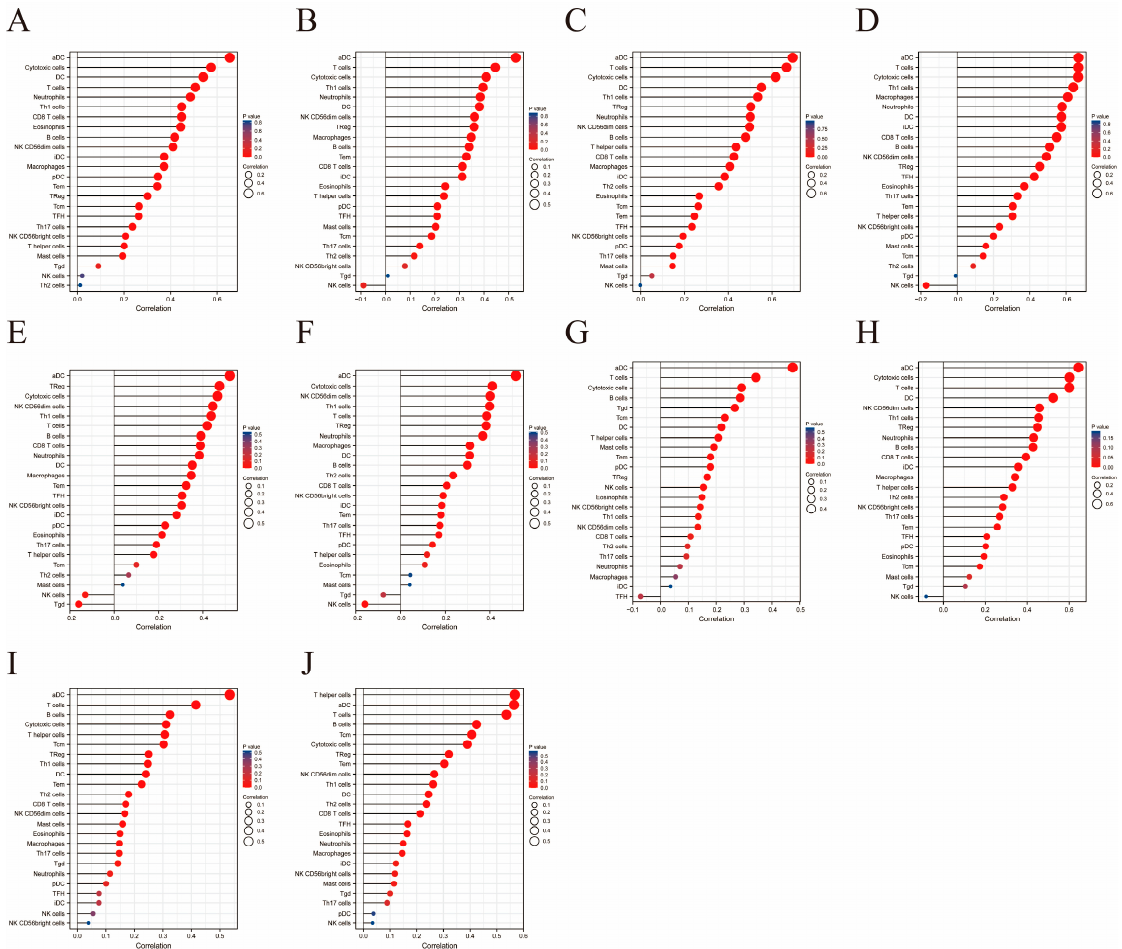
Figure 5. Immune cell infiltration analysis performed on the ten hub genes, presented in the form of lollipop charts. ( A – J ) Lollipop charts for BST2, IFITM1, IRF1, IRF5, IRF7, ISG15, MX1, PSMB8, RSAD2, STAT1, respectively.